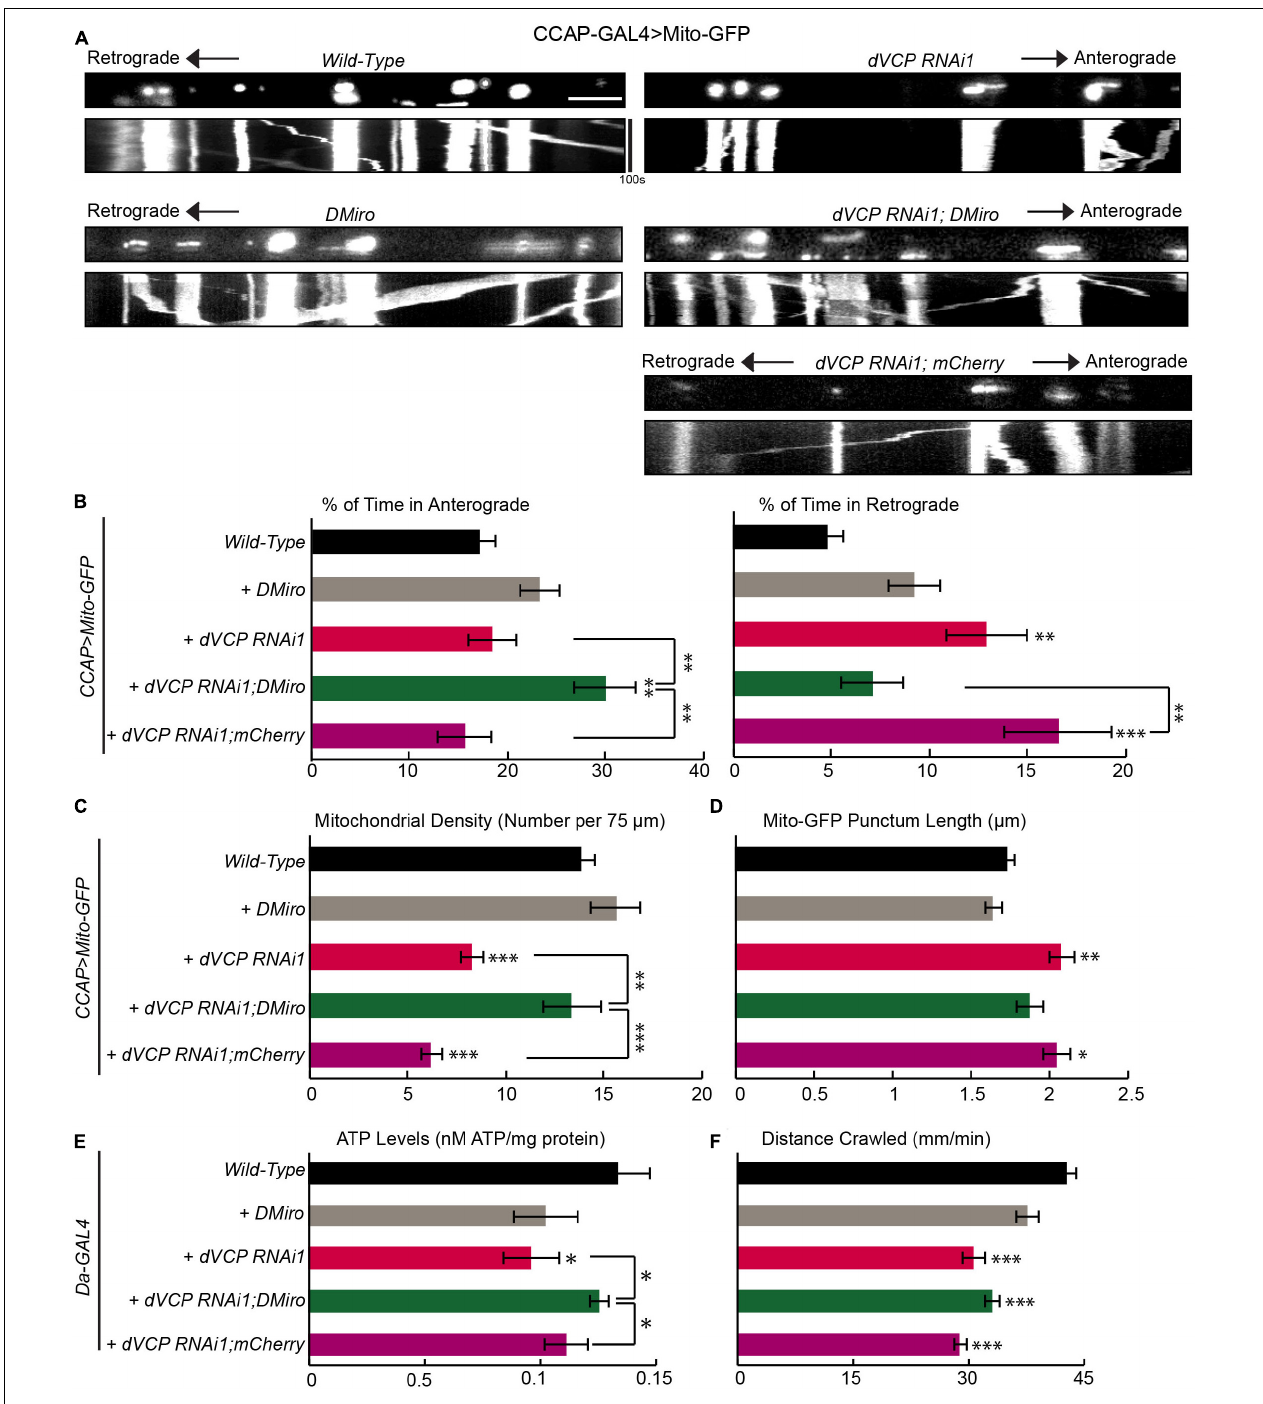
FIGURE 3 | Overexpression of fly Miro rescues defects in mitochondrial transport caused by dVCP RNAi. (A) Mitochondrial movement labeled by Mito-GFP driven by CCAP-GAL4 in representative axons passing segment A3. The first frame of each live-imaging series is shown above a kymograph generated from the movie. (B) The percent of time each mitochondrion spends moving in the anterograde and retrograde directions is determined and averaged ( n = 125–344 mitochondria). (C) The density of mitochondria (number per 75 µ m) is shown ( n = 12–28 axons). (B,C) Two-way ANOVA test reveals a significant difference between DMiro ’s impact on wild-type and on dVCP RNAi for retrograde movement ( P < 0.001) and near significant difference for density ( P = 0.088). (D) The length of each Mito-GFP punctum is quantified and averaged ( n = 125–344 mitochondria). For B–D , 12–28 axons were imaged from 6–12 larvae per genotype. Comparisons with “ CCAP-GAL4 > Mito-GFP, Wild-Type ” (same data as in Figure 1 ) unless otherwise indicated. (E) Quantification of the total ATP level normalized to the protein concentration in third instar larvae ( n = 5–6 larvae). (F) Larval locomotor ability was determined by the average distance in mm crawled in 60 s ( n = 47–75 larvae). For E,F , comparisons with “ Da-GAL4 > Wild-Type ” unless otherwise indicated. Scale bar = 7.5 µ m. * P < 0.05, ** P < 0.01, *** P < 0.001.